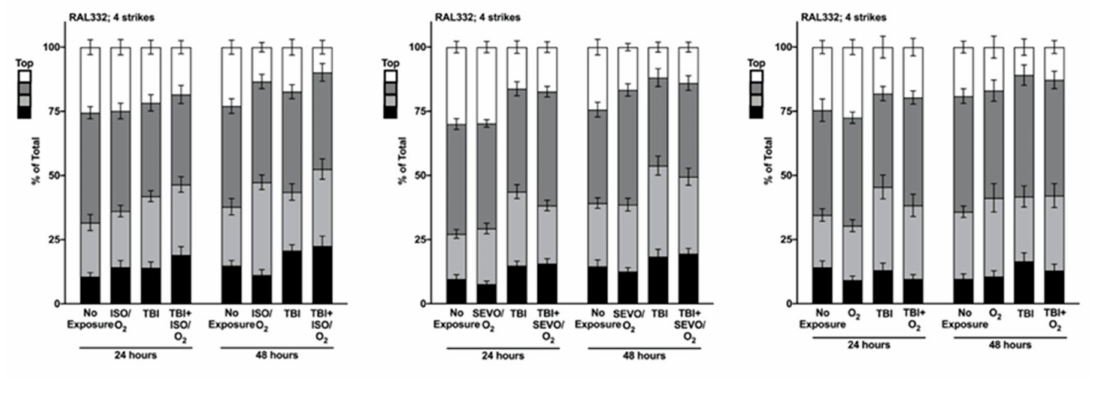
Figure A10. RAL818.